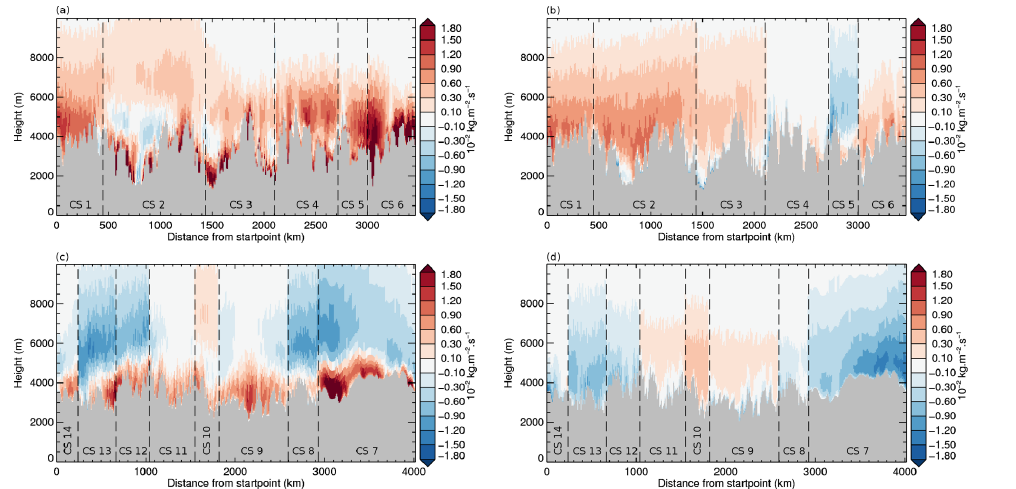
Figure 9. Decadal average of the atmospheric water transport (10 − 2 kgm − 2 s − 1 ) for cross sections 1–6 ( a and b ) (from left to right, dashed lines indicate border between the cross sections) in July (a) and January (b) , and for cross sections 14–7 ( c & d ) in July (c) and January (d) for HAR10. Red colours denote transport towards the TP, while blue colours indicate transport away from the TP. The underlying topography is represented in